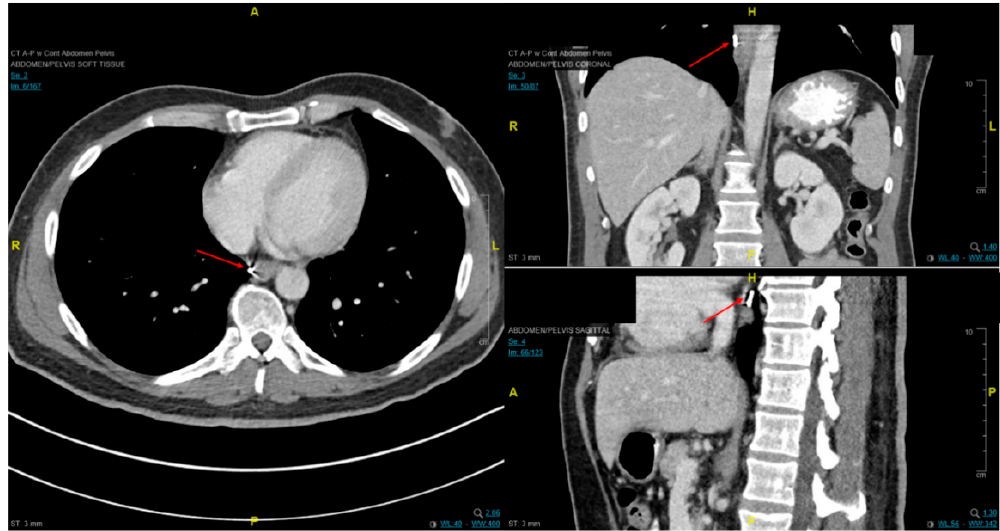
Figure 7. Axial, coronal, and sagittal CT images demonstrating EUS-placed fiducial (red arrow) proximal to esophageal tumor.